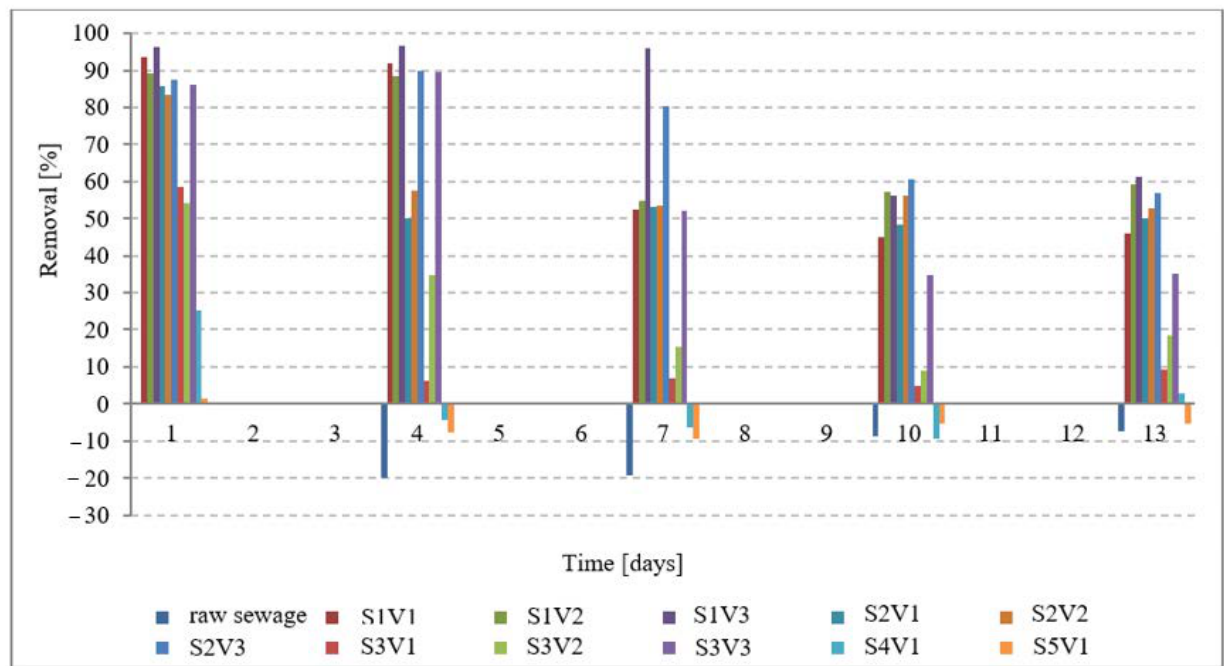
Figure 7. Odor removal across variants.